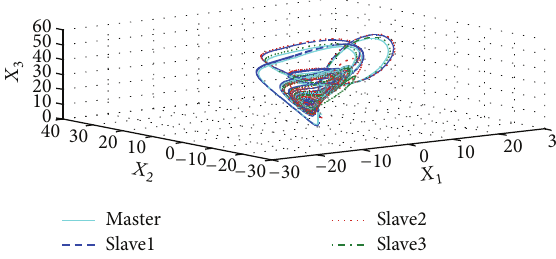
Figure 2: Phase portrait of the master-slaves